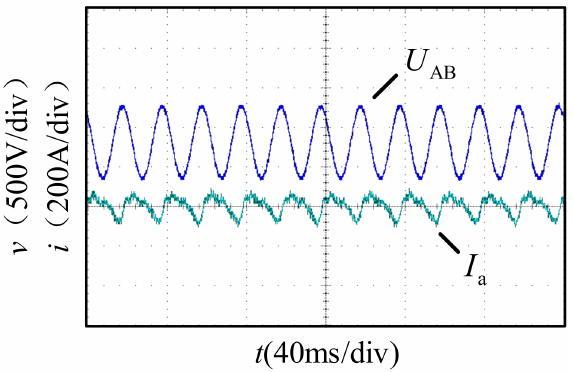
Figure 18. Experimental waveform of single inverter after control.